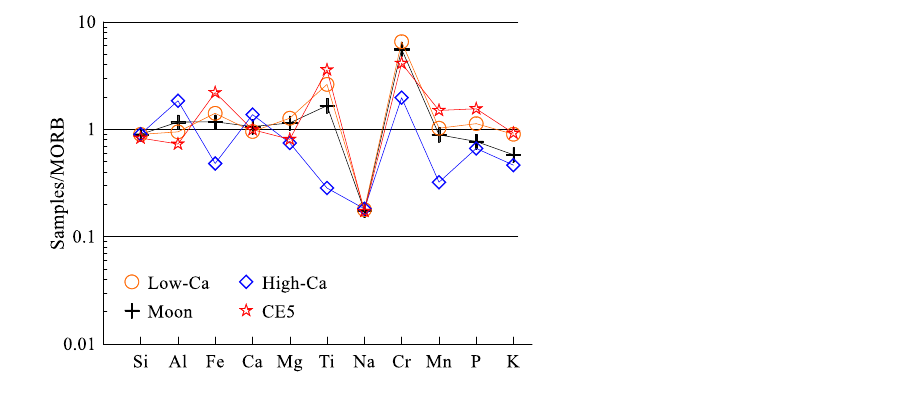
Figure 3. Spider diagrams of major oxides of moon samples normalized based on MORB. Abundances of the MORB are from White and Klein [14]. Elements in the horizontal axis are the abbreviations of their major oxides listed in Table 2.